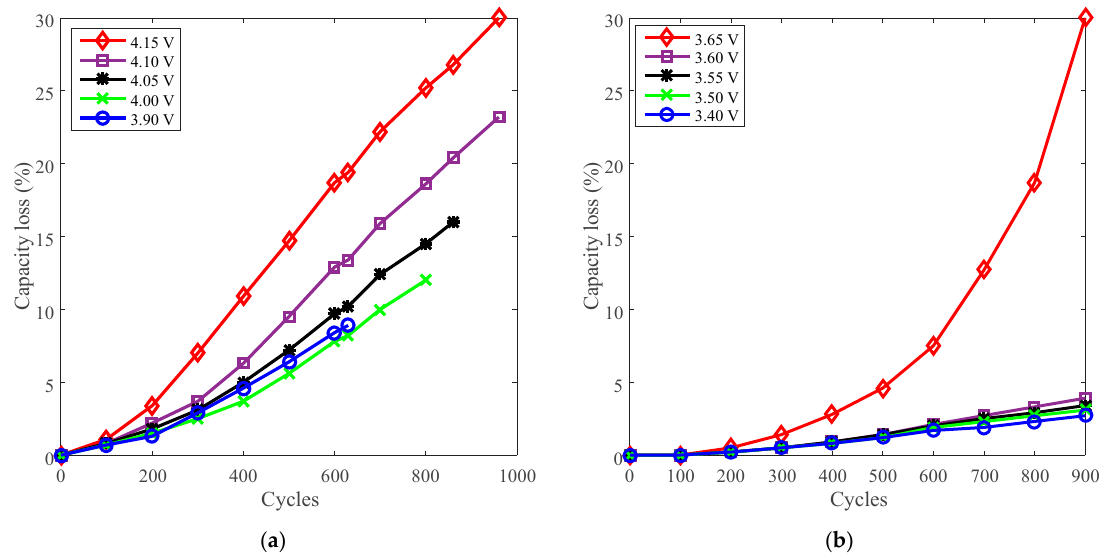
Figure 12. Battery cycle degradation data under various charge cut-off voltages. (a) “4.15 V” refers to battery J charged at CC 3 A (2.7C) to 4.15 V, then CV to 100 mA (C/11), and finally discharged at CC 3 A to 2.5 V under 25 °C. (b) “3.65 V” refers to battery K charged at CC 3 A (2.7C) to 3.65 V, then CV to 100 mA (C/10), and finally discharged at CC 3 A (2.7C) to 2.0 V under 25 °C . The capacity loss vs. charge cut-off voltage of battery J and K are plotted in Figure 13(a). The rated voltages, 4.1 V for battery J and 3.6 V for battery K, are selected as the reference conditions. The derating of charge cut-off voltage is presented in Figure 13(b).